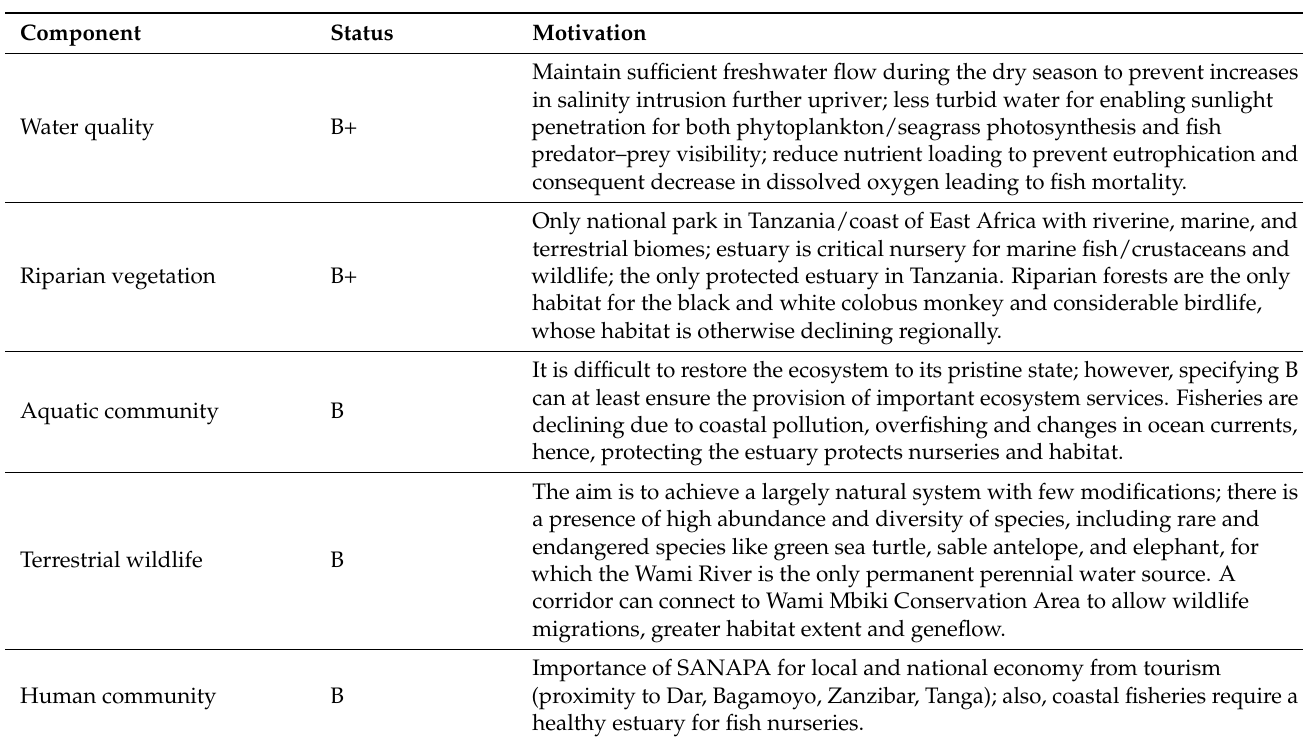
Table 5. Restoration goals.